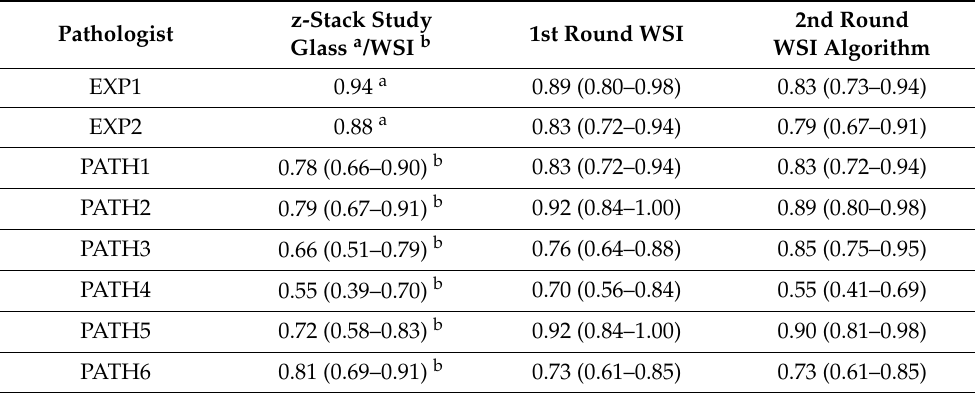
Table 2. Kappa values (95% confidence interval) for all cases excluding nevoid melanoma ( n = 89). a Glass; b